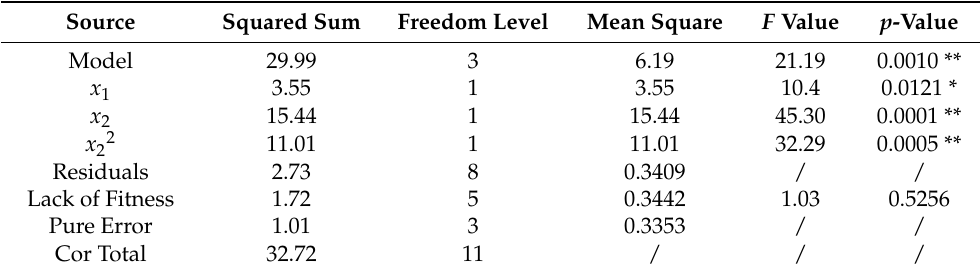
Table 4. QRNDSM variance analysis.